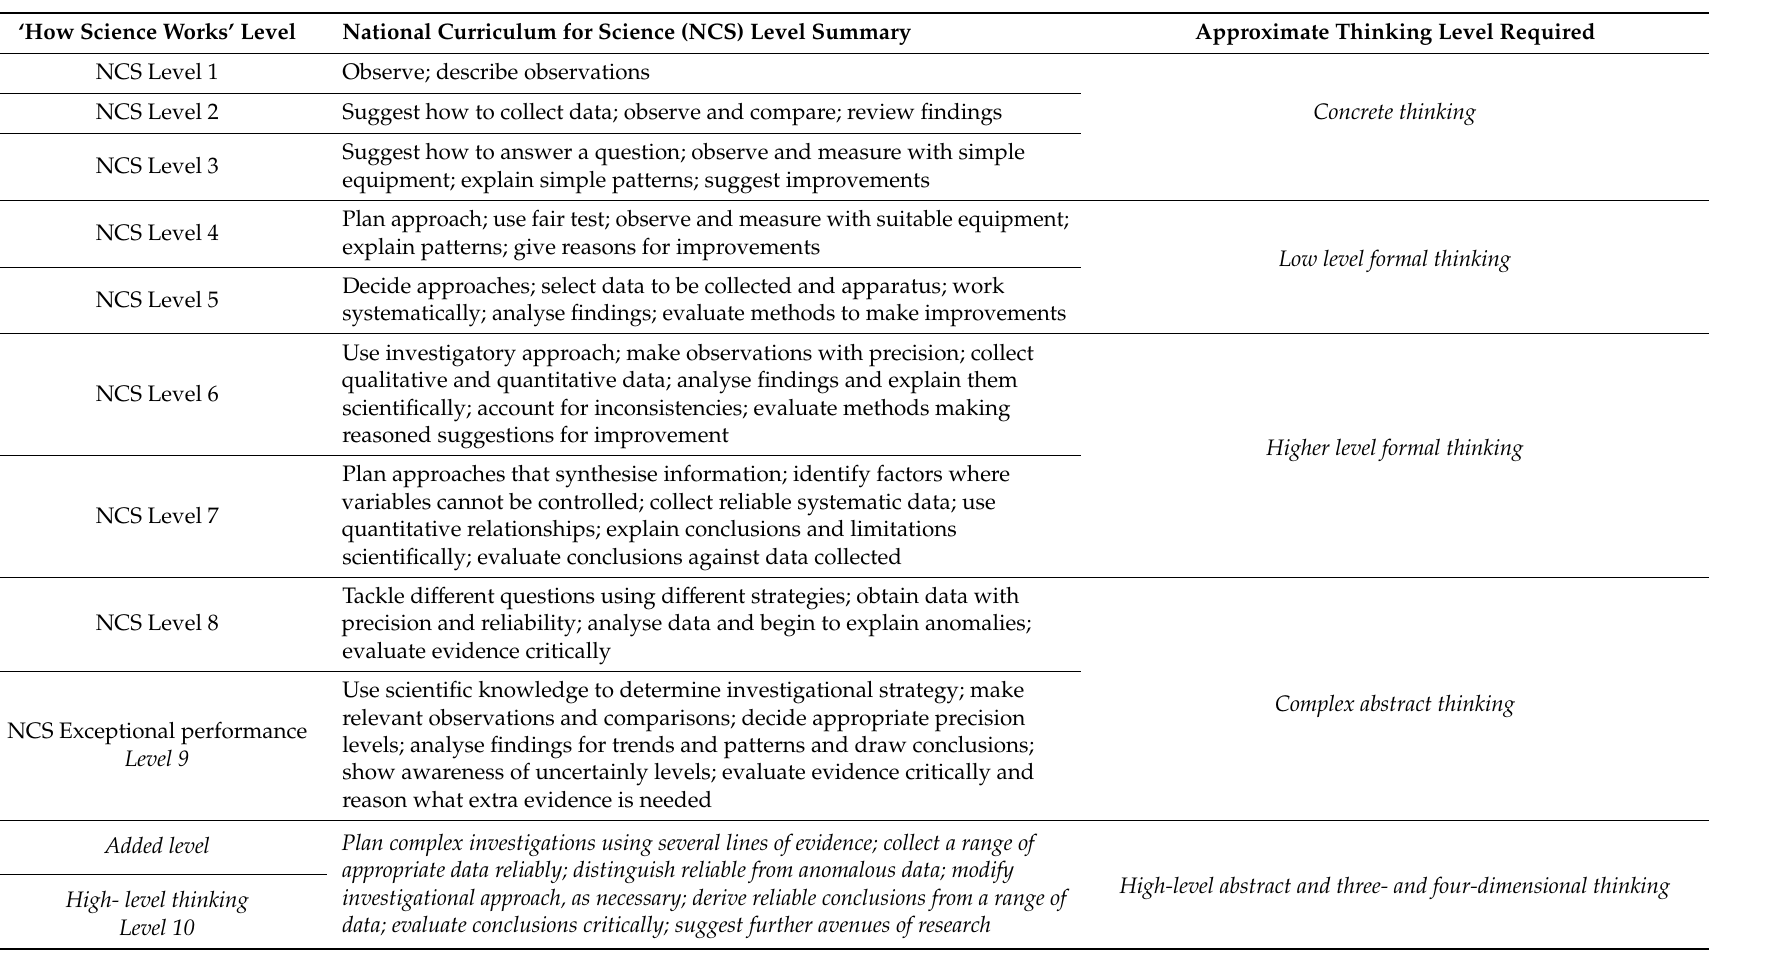
Table 1. ‘How science works’ descriptor table, based on abbreviated ‘ How science works’ level descriptors (National Curriculum for Science in England (QCA, 2007), with the additions shown in italics of Level 9, the NCS ‘Exceptional performance’ level descriptor, and Level 10 adapted from Mogk and Goodwin [53] (53:138), as explained in the